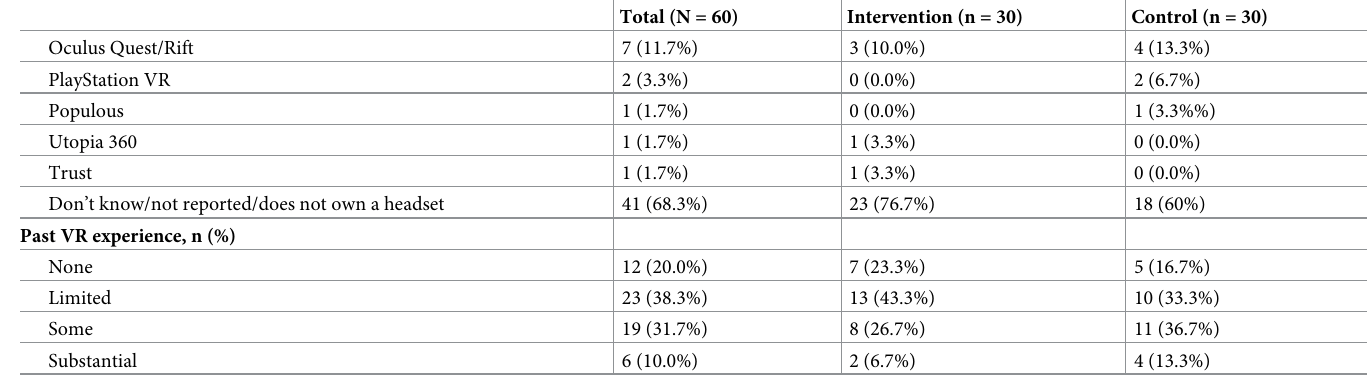
operationalised as continuous variables, there were no significant differences between the intervention and control scenarios (Table A in S1 Table).